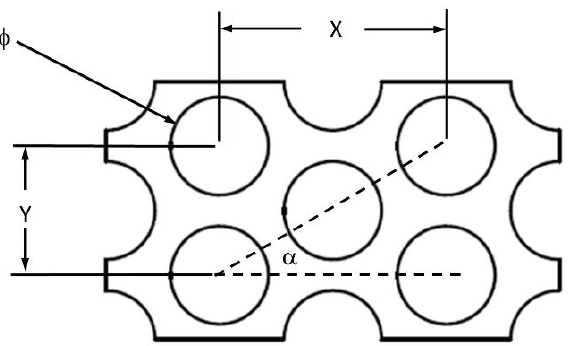
Figure 2. Pertinent screen dimensions and geometry for top, middle and bottom screens (see Table 1). The angle α was 30 degrees for all screens.